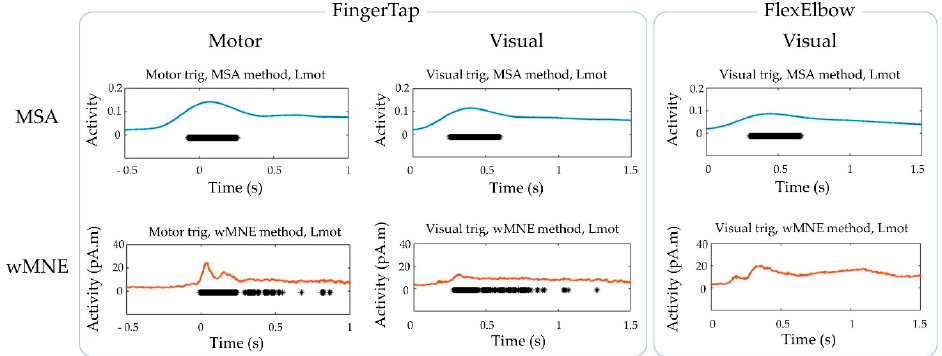
Figure 6. Group-level statistics for the “FingerTap” and the “FlexElbow” experiments. Significant time points obtained in the Lmot region on average across participants using the MSA and wMNE